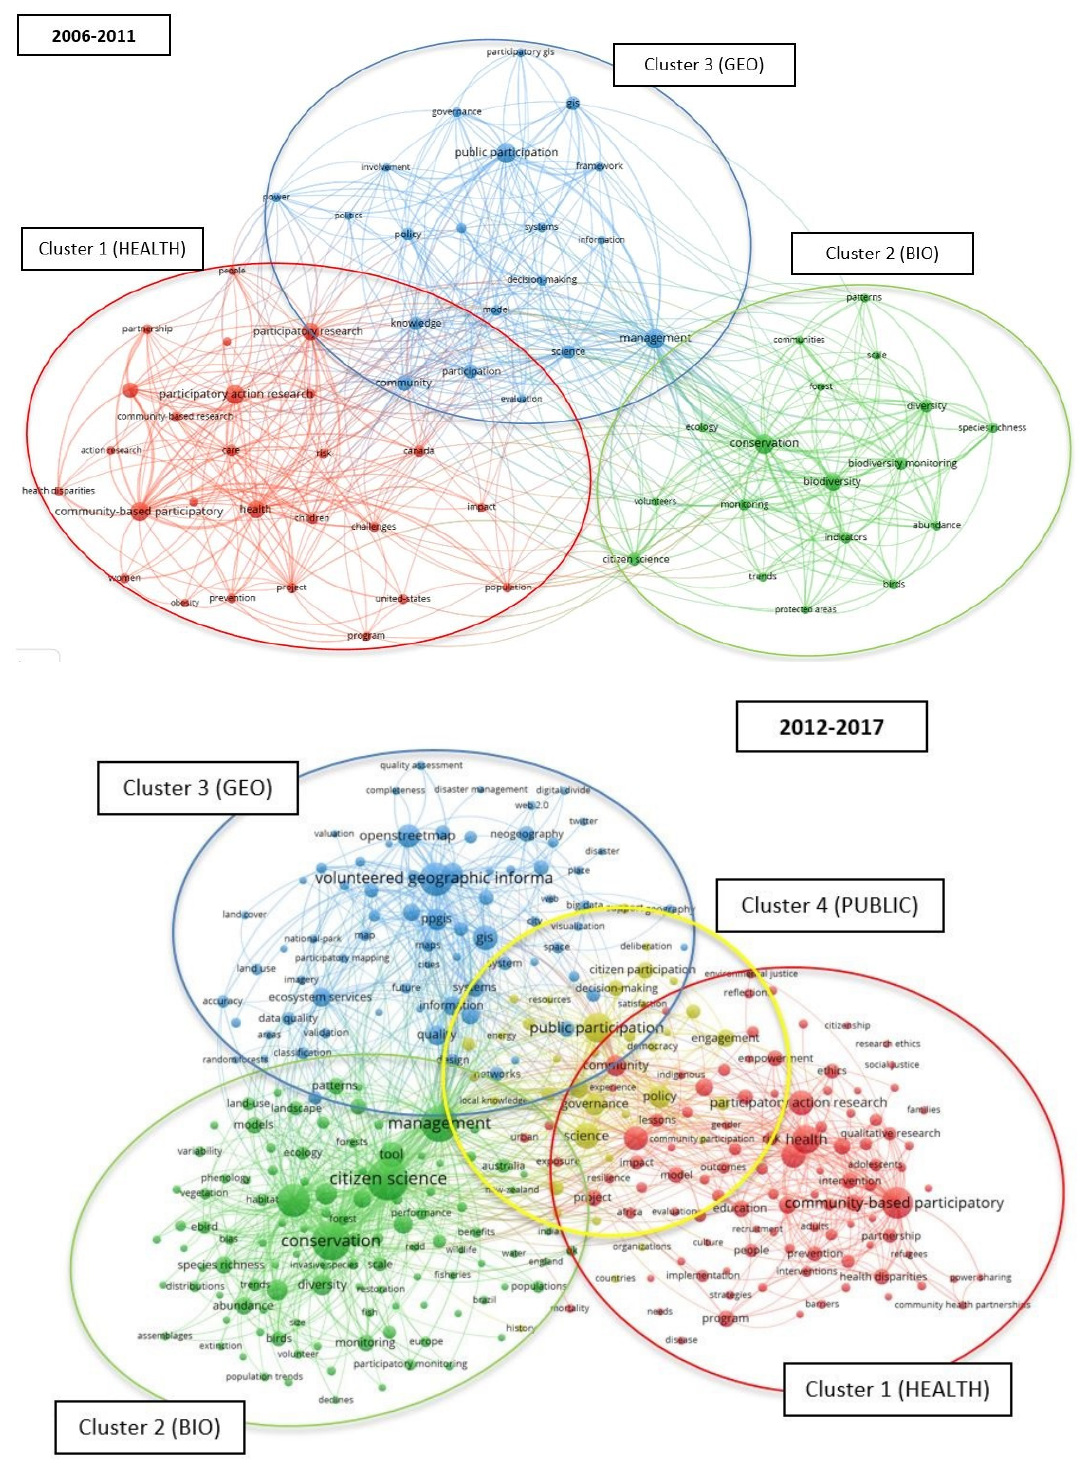
Figure 6. Co-occurrence map of subject areas with ≥ 15 documents on citizen science (CS): comparison between two 6-year periods.